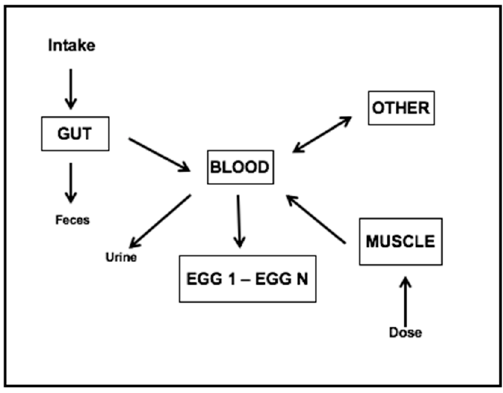
Figure A2. Model diagram representing 14 C-B12 kinetics in laying hens. 14 C-B12 is transferred between blood, muscle, gut, all other tissues, and deposited in each egg from egg number 1 to N.